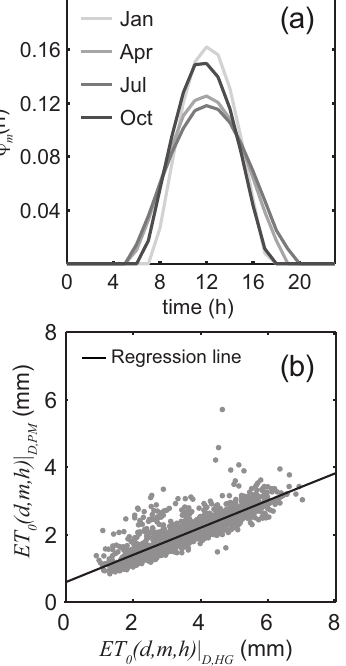
Fig. 7. (a) Dimensionless function φ m (h) for the months January, April, July and October, and (b) scatterplot between the daily ET 0 computed with the PM and HG formula during the spring season (MAM), along with the regression lines.